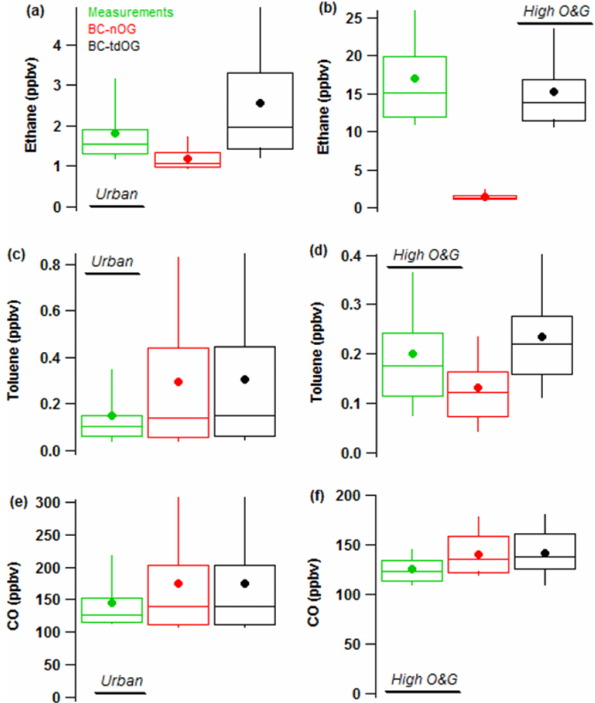
Figure 5. Comparison of the measured and WRF-Chem-predicted (no O&G and top-down O&G emission scenarios) mixing ratios of ethane ( a and b ), toluene ( c and d ), and CO ( e and f ) in urban- and high-O&G-influenced plumes. Box and whisker plots depict the 10th, 25th, 50th, 75th, and 90th percentiles. Mean values are shown in